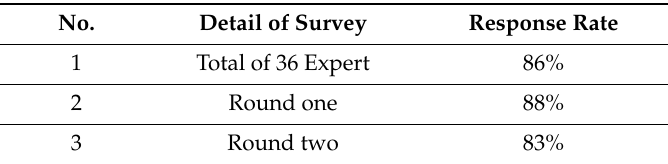
Table 2. The response rate of round 1 and round